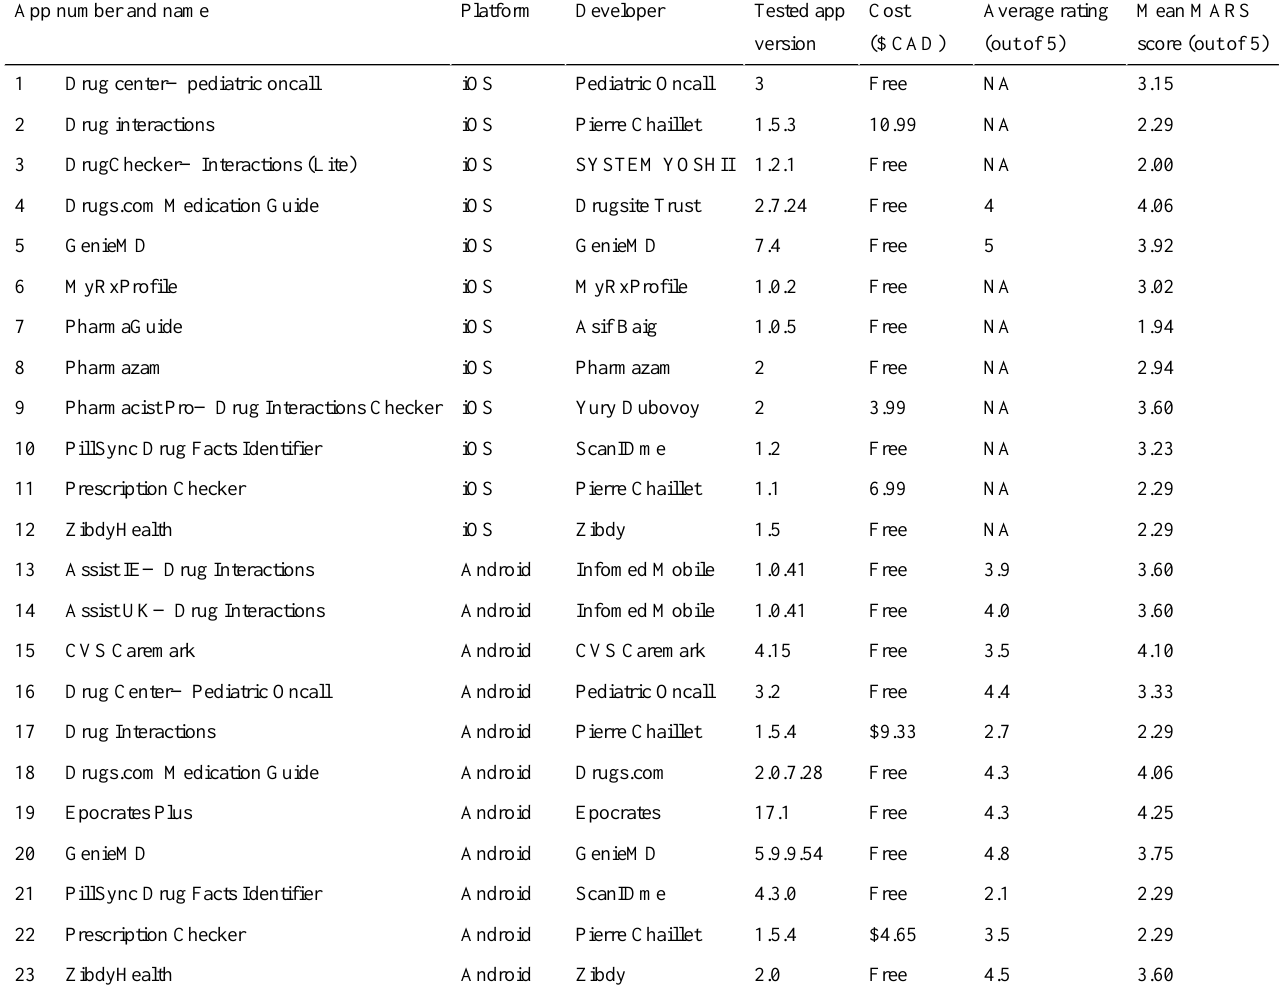
Table 1. General information about the eligible apps, developer, tested version, cost, average rating, and mean Mobile App Rating Scale (MARS) score. iOS: iPhone operating system. NA: not